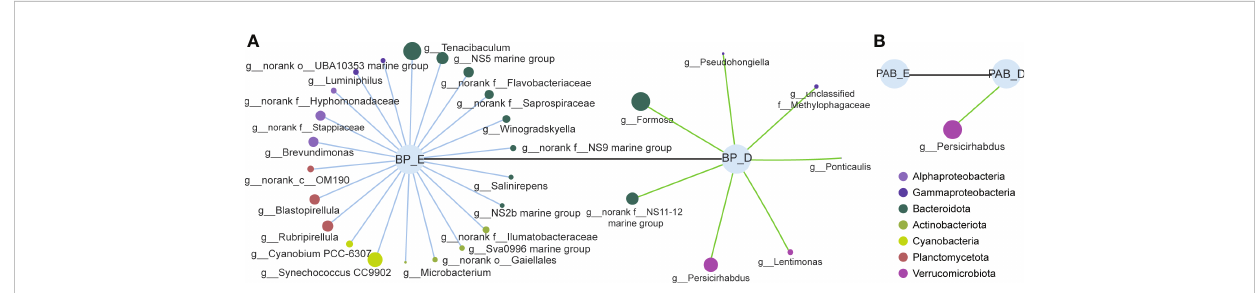
FIGURE 6 The abundance of bacterioplankton (A) and particle-attached bacteria (B) with signi fi cantly differences between exponential and decline growth phase of Phaeocystis globosa bloom. Radiating dots represent bacterial genus, and the dots size and color represent their abundance and phylum they belong to. BP, bacterioplankton; PAB, particle-attached bacteria; E, exponential growth phase of bloom; D, decline growth phase of bloom. ( p <